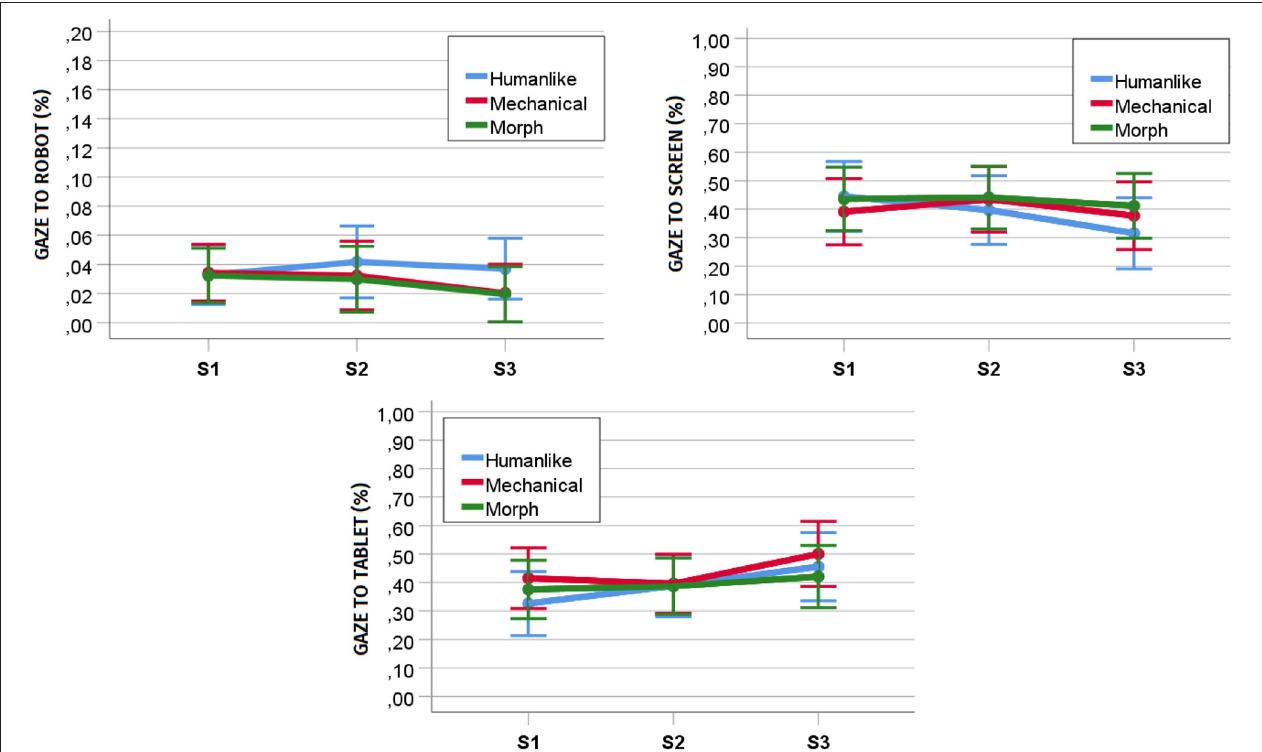
FIGURE 7 | Development of percentage of gaze toward the robot, the screen, and the tablet over the three sessions of the game interaction. S1, Session 1; S2, Session 2; S3, Session